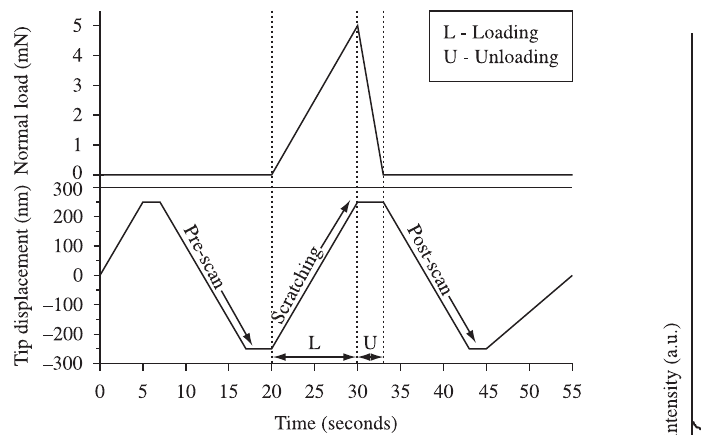
Figure 1. Loading-displacement functions applied to Berkovich tip for scratch tests on the deposited Ti-doped carbon coatings.